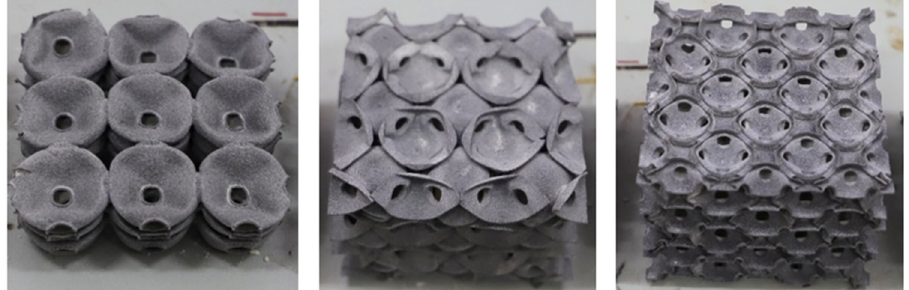
Figure 8. Compressed hollow sphere structures.